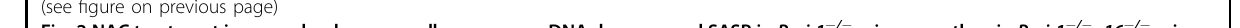
TGF- β 1, IL-11, and IL-11 receptor α 1 (R α 1) compared with those of WT mice; protein levels of collagen 1, α - SMA, mature TGF- β 1 and IL-11 and mRNA levels of Col1a1 , Col1a2 , ACTA2 , PAI-1 , TGF- β 1 , MMP9 , MMP12 ,